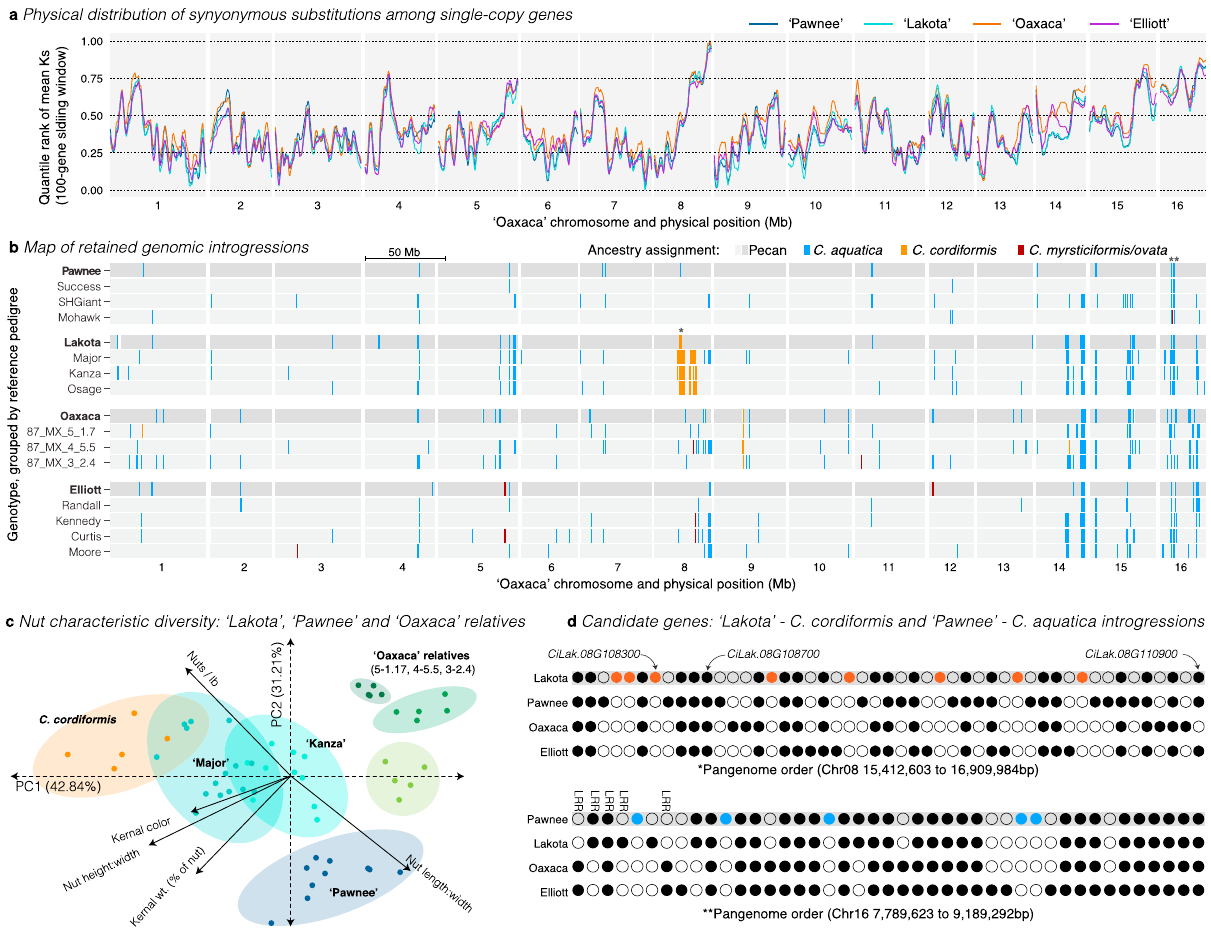
Fig. 2 A map of interspeci fi c genomic introgressions in four pecan genomes. a Sliding window analysis of neutral site substitution rate ( K s ) within all single-copy orthogroups that were represented by all four genomes. K s values were transformed to quantiles and a 100-gene sliding window was applied within each chromosome and genome. The resulting sliding window values are presented on a 0 – 1 scale where lower values represent the most similar regions across the physical genome (Mb: megabases). See Supplementary Fig. 2 for raw pairwise K s values. Close-up pan-genome representations of two regions marked * and ** are highlighted in d . b Genome ancestry maps of the four reference genomes and representative members of each pedigree. Posterior probabilities of ancestry for three primary hybridizing species were decoded into blocks (colors red, orange, blue) of ≥ 500 variants. The background pecan ancestry is dark and light gray for the reference genomes and relatives respectively. c The large introgression in the ‘ Major ’ and ‘ Kanza ’ relatives of ‘ Lakota ’ appear to imbue phenotypic variation typical of C. cordiformis to these genotypes. 13 traits associated with nut yield and quality were assayed for a single C. cordiformis genotype (02-COR-LA-BF1), ‘ Pawnee ’ , two members of the ‘ Lakota ’ pedigree ( ‘ Major ’ and ‘ Kanza ’ ) and three genotypes from Mexico that may be related to ‘ Oaxaca ’ . The 13 traits were reduced to fi ve non-collinear (| r | < 0.75) representatives and decomposed into the two major principal component axes (PC1, PC2), which collectively explained >74% of the variation. For each genotype, we present the positions in PCA space and the 95% con fi dence ellipse. d Pan-genome gene representatives are shown for each unique orthogroup within two physical (base pairs, bp) introgression intervals. Circles represent presence ( fi lled) or absence (open) for each genome (row) by orthogroup (column) in the introgression. The fi rst row in each plot represents the genome into which an introgression was observed. Private orthogroups to that genome are colored following panel b . Three candidate genes in ‘ Lakota ’ and the dense region of leucine-rich repeat (LRR) genes are annotated along the top row of each map. Source data underlying Fig. 3a – c are provided as a Source Data fi le. Raw data associated with d can be found within the pangenome database in Supplementary Data